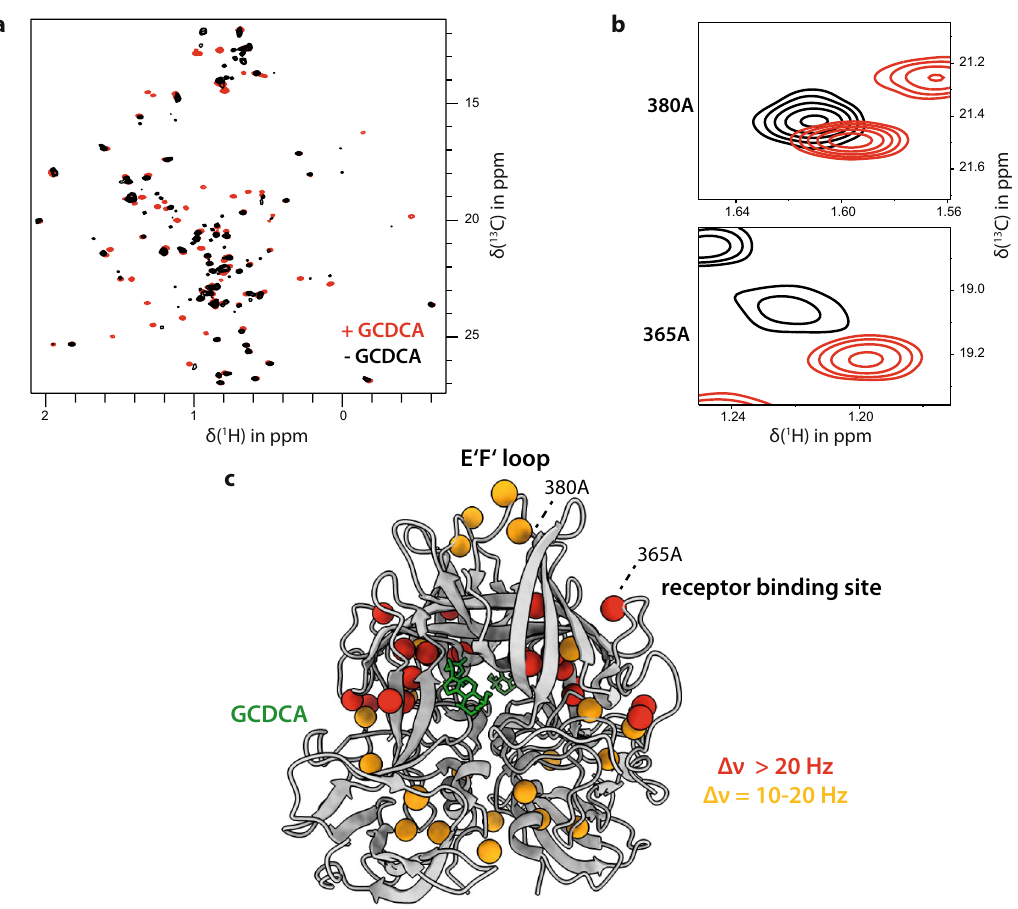
Fig. 4 Chemical shift perturbations in MNV CW1 P-domains upon GCDCA binding. a Methyl TROSY spectra of 50 µ M 13 C-methyl group-labeled (MILVA-labeled) MNV P-domains (black spectrum) and titrated with 550 µ M GCDCA (red spectrum). b The spectra reveal CSPs ( Δν Eucl , see Table S3) also in regions up to 20 Å apart from the GCDCA binding pocket. c Medium (orange) and large (red) CSPs mapped onto the crystal structure model of the MNV P-domain (PDB 6E47). For the division of signi fi cant CSPs into “ small ” , “ medium ” , and “ large ” effects cf. Figs. S16,